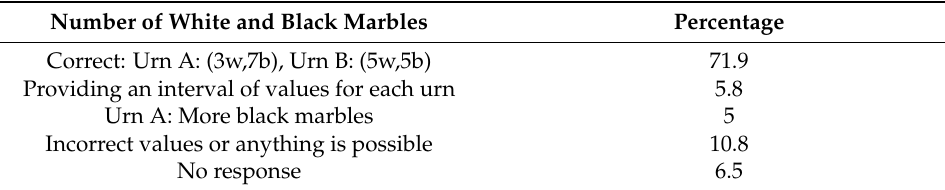
Table 1. Proposed composition of urns in Task